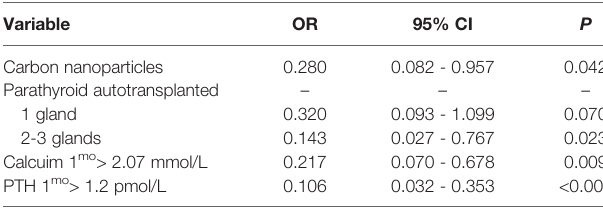
TABLE 3 | Multivariate analysis for predicting permanent hypoparathyroidism in patients with protracted hypoparathyroidism.